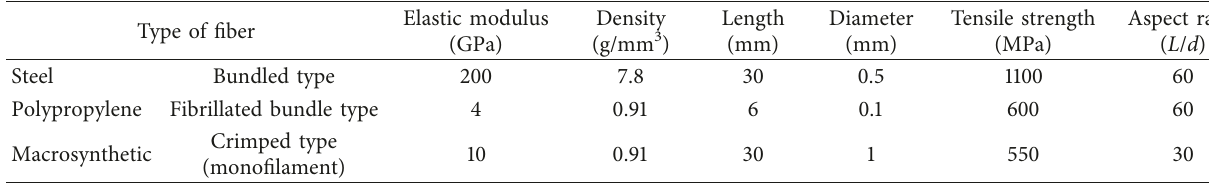
Table 4: Properties of fibers.